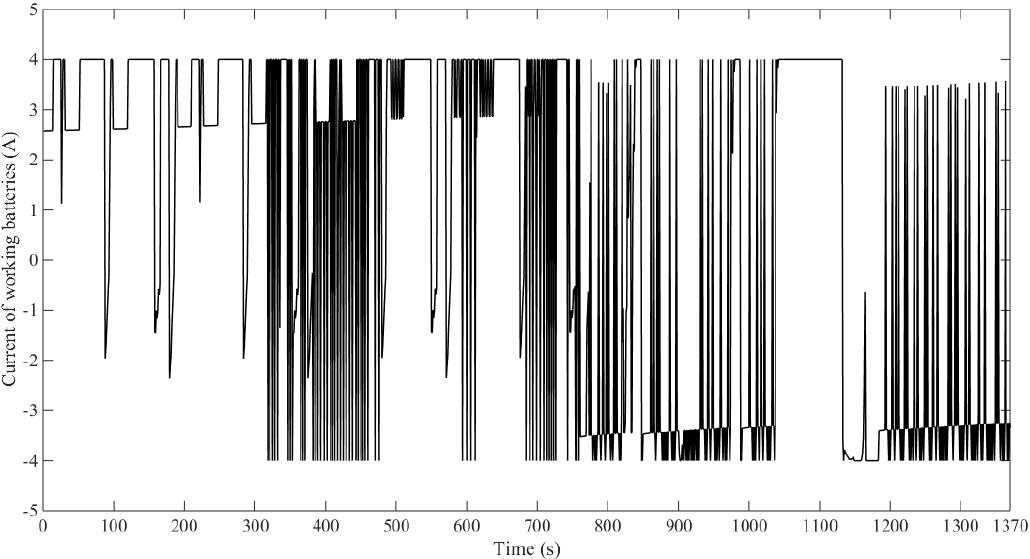
Figure 15. The SOC change of each battery.